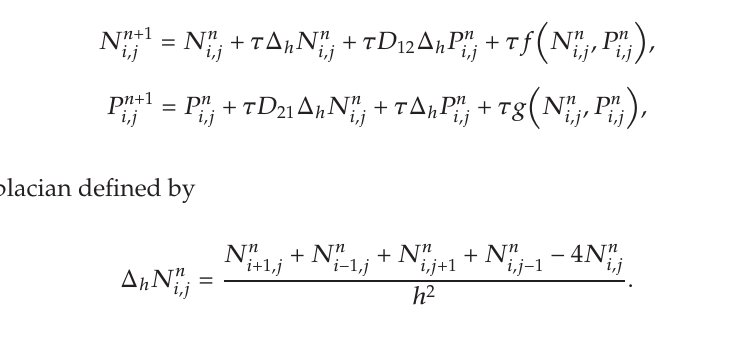
Figure 2: Bifurcation diagram for model (cid:7) 1.1 (cid:8) with parameters a (cid:6) 0 . 8 ,b (cid:6) 0 . 1, and D 21 (cid:6) 0 . 8. The Turing (cid:6) (cid:7) 707983156 D 2 − (cid:7) 7436338235 (cid:9) 50000 A (cid:8) D (cid:9) 8189199110 − 62500 A (cid:8) / (cid:7) 10 9 (cid:7) D bifurcation line is r (cid:8) 12 12 T − D − 5 (cid:8)(cid:8) , where A (cid:6) − 8 . 784 D (cid:8) . Hopf bifurcation line is r 1 (cid:8)(cid:7) 4 D 2 10 9 (cid:7) 14 . 63 − 2 . 336 D 2 12 12 12 12 Turing and Hopf lines intersect at the Turing-Hopf bifurcation point (cid:7) D 12 ,r (cid:8) (cid:6) (cid:7) − 0 . 00489 , 0 . 12572 (cid:8) and separate the parametric space into four